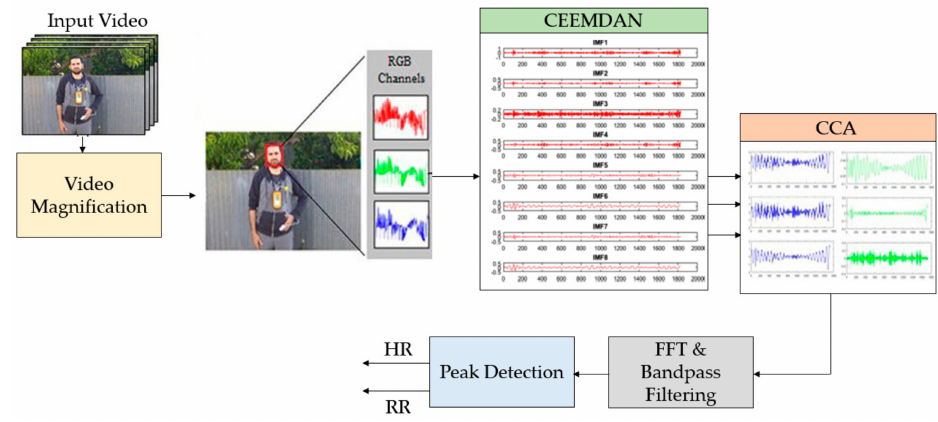
Figure 7. System overview of the noise removal technique using a UAV